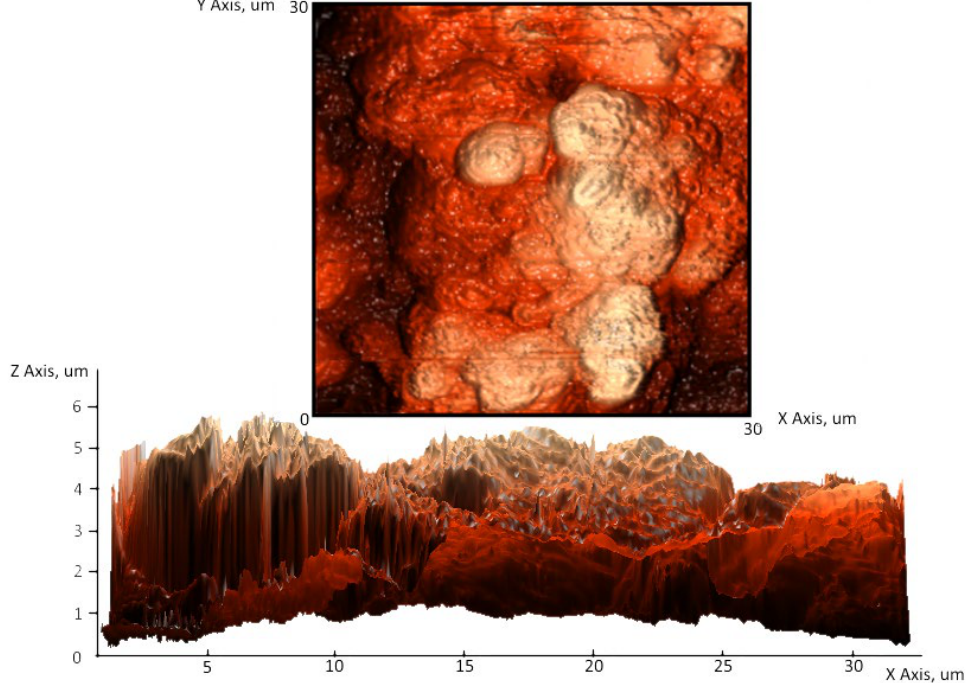
Figure 1. Height map of the hydrophobic layer obtained using a NTEGRA II scanning electron microscope. The average roughness of a surface fragment equals 0.922 µm. The roughness shown in the figure is created by OLC agglomerates. Separate OLCs or larger irregularities are unresolved with a